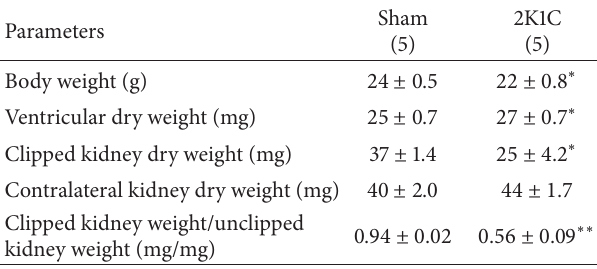
Table 1: Body, ventricular, and kidney weights of 2K1C and Sham mice 14 days after renal artery